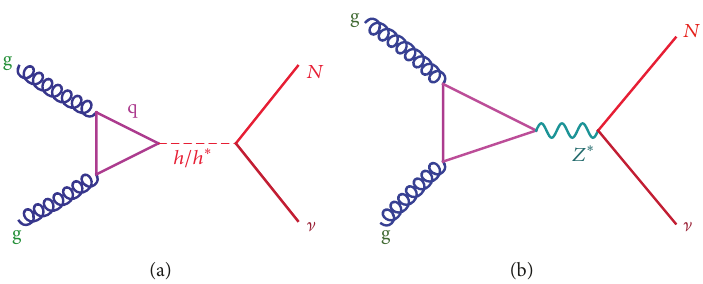
Figure8:ggFproductionoftheheavyneutrinosfromHiggs (ℎ) and 𝑍 bosons. ℎ → 𝑁 ] canbepromptwhen 𝑚 ℎ > 𝑚 𝑁 givinganenhancement to the 𝑁 ] production from the ggF channel. For 𝑚 ℎ < 𝑚 𝑁 , off-shell Higgs (ℎ ∗ ) produces 𝑁 ] final state. Similarly off-shell 𝑍 (𝑍 ∗ ) can also produce 𝑁 ] final state when 𝑚 𝑁 > 𝑚 𝑍 . For the Higgs mediated case, top quark loop will contribute dominantly whereas for the 𝑍 ∗ case all contributions coming from the quarks will be counted according to its coupling with the